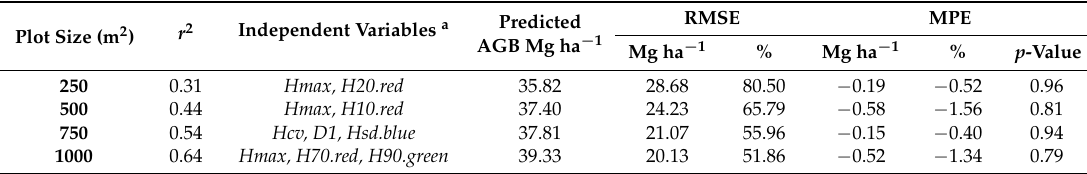
Table 4. Model performance over different sample plot sizes *.